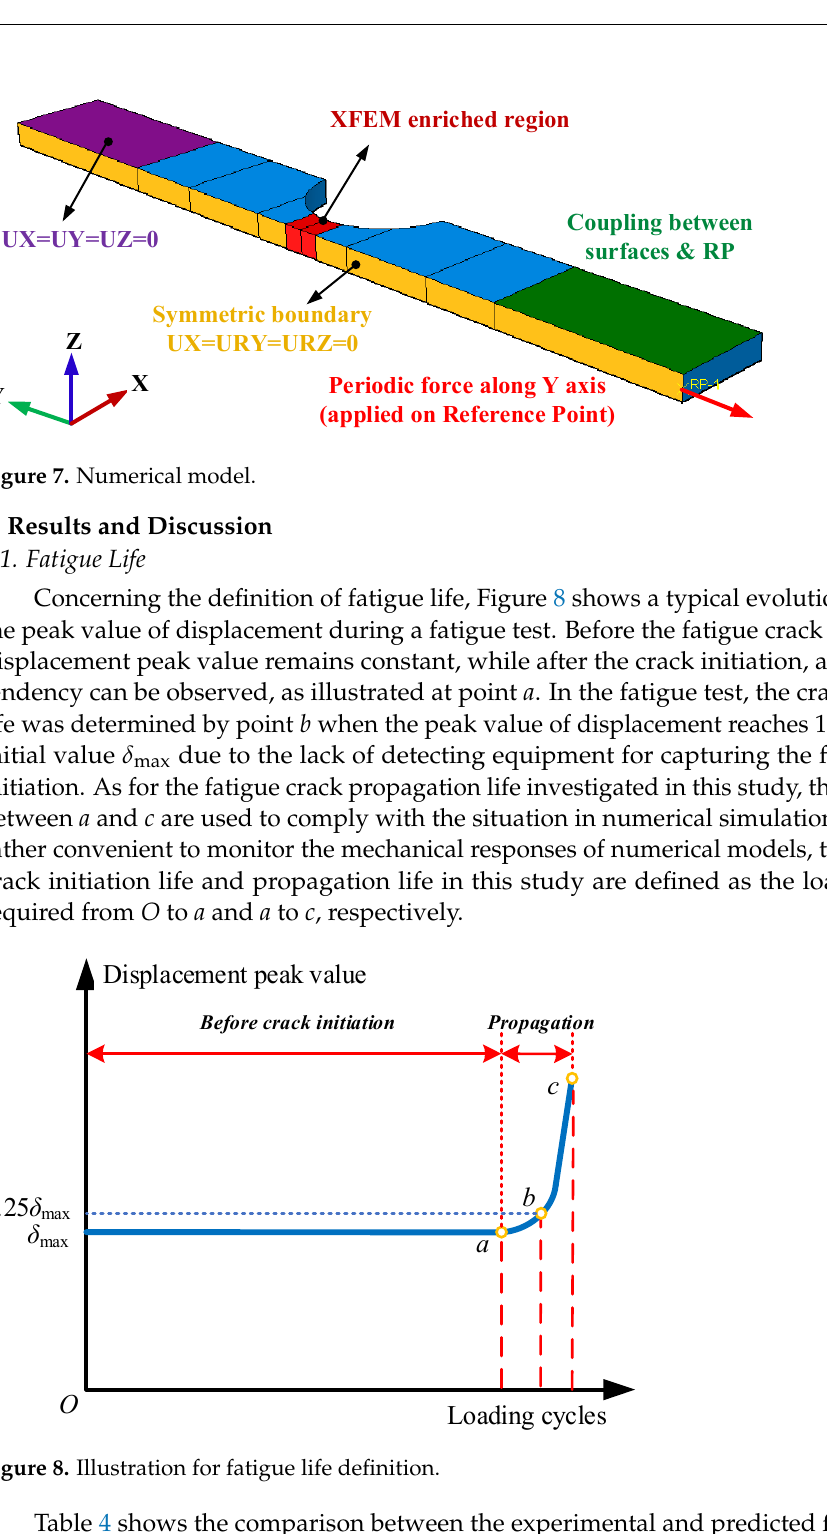
Figure 7. Numerical model.